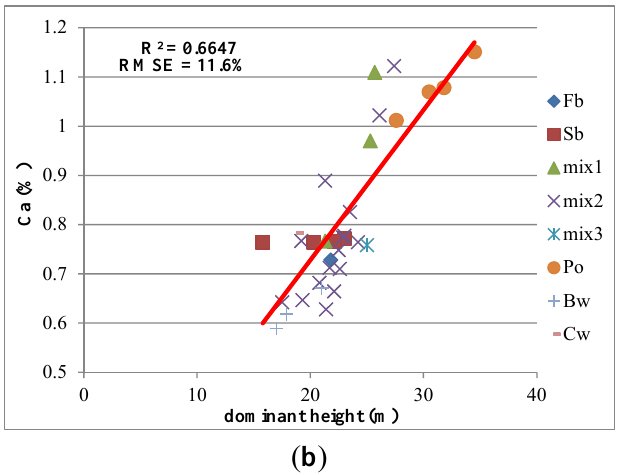
Figure 5. The relationship between ( a ) N concentration and crown closure, and ( b ) Ca concentration and dominant height at the plot level. Red line is the linear fit. Bf = balsam fir; Sb = black spruce; Po = trembling aspen; Bw = white birch; Cw = white cedar; mix1 = mixed deciduous; mix2 = mixed deciduous and conifer; and mix3 = mixed